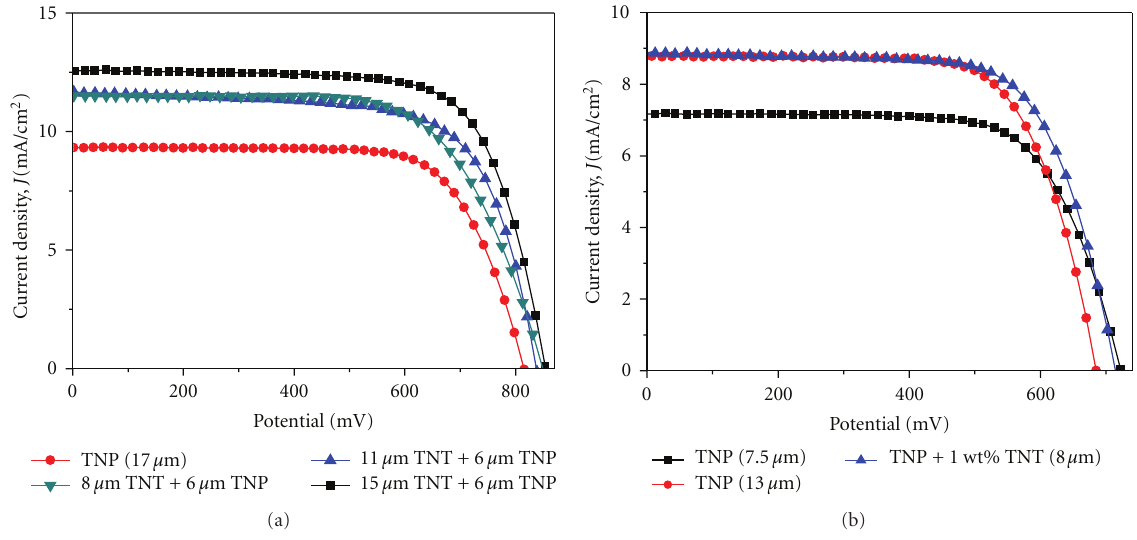
Figure 5: Current density-voltage (J-V ) characteristics of di ff erent DSSCs of cell type-A (a) and cell type-B (b).